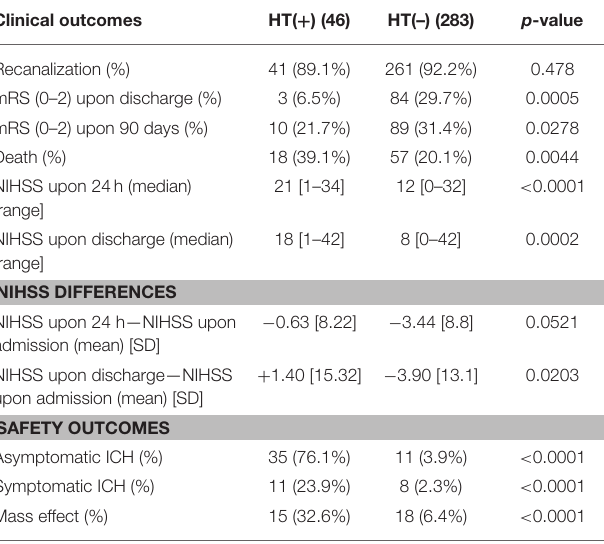
TABLE 3 | Results from the univariate statistical tests performed on safety outcome rates and patient outcomes between HT( + ) and HT(–) patient groups. Clinical outcomes HT( + ) (46)